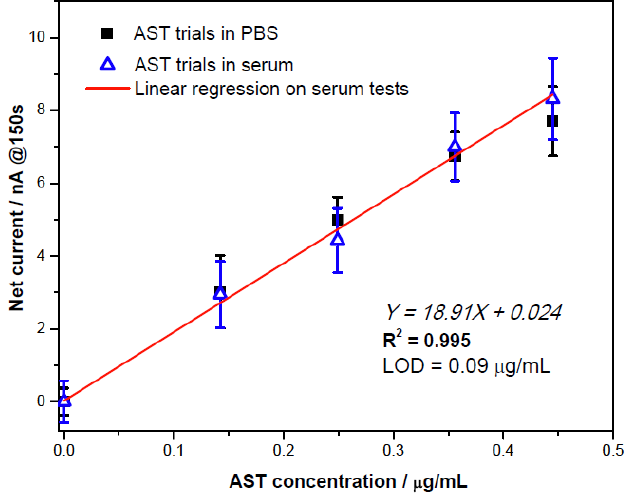
Figure 6. Comparable results for ALT detection in phosphate buffer and human serum